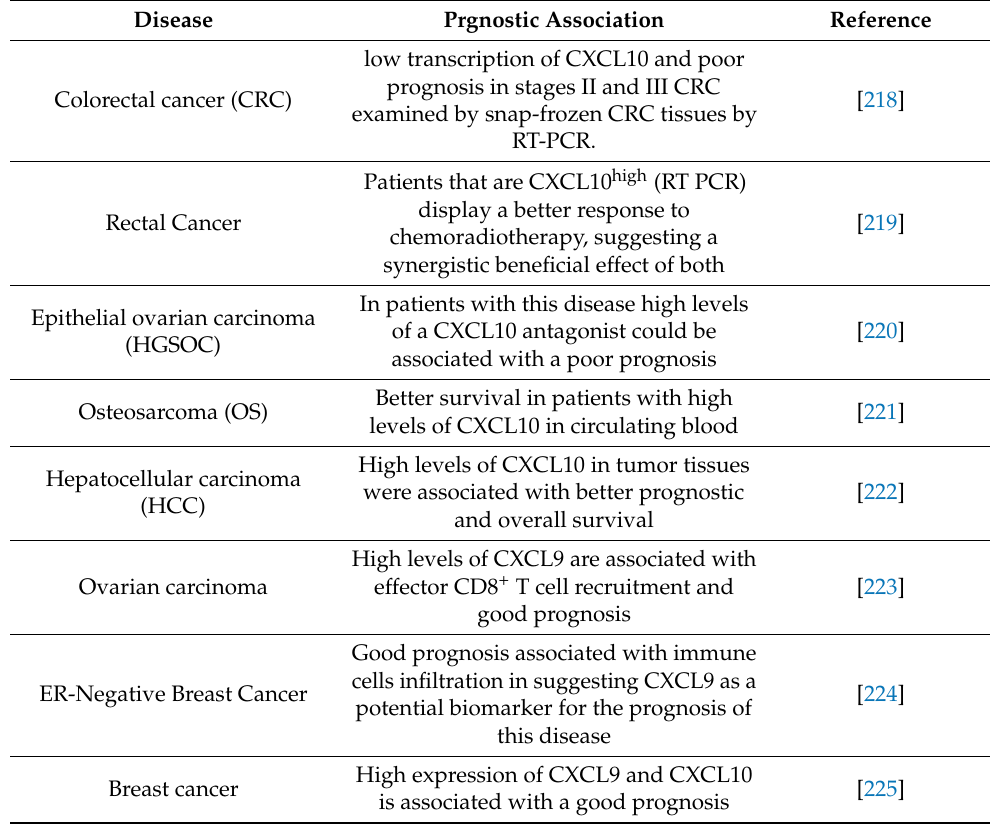
Table 1. Association of CXCL10/ CXCL9 with cancer prognosis in human. Disease Prgnostic